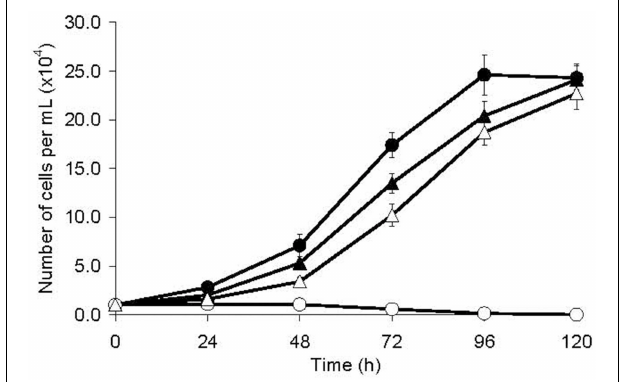
FIGURE 1 | Growth kinetics of HM-1 (circles) and MTZR (triangles) cultured with (open symbols) or without (filled symbols) 12 µ M MTZ.